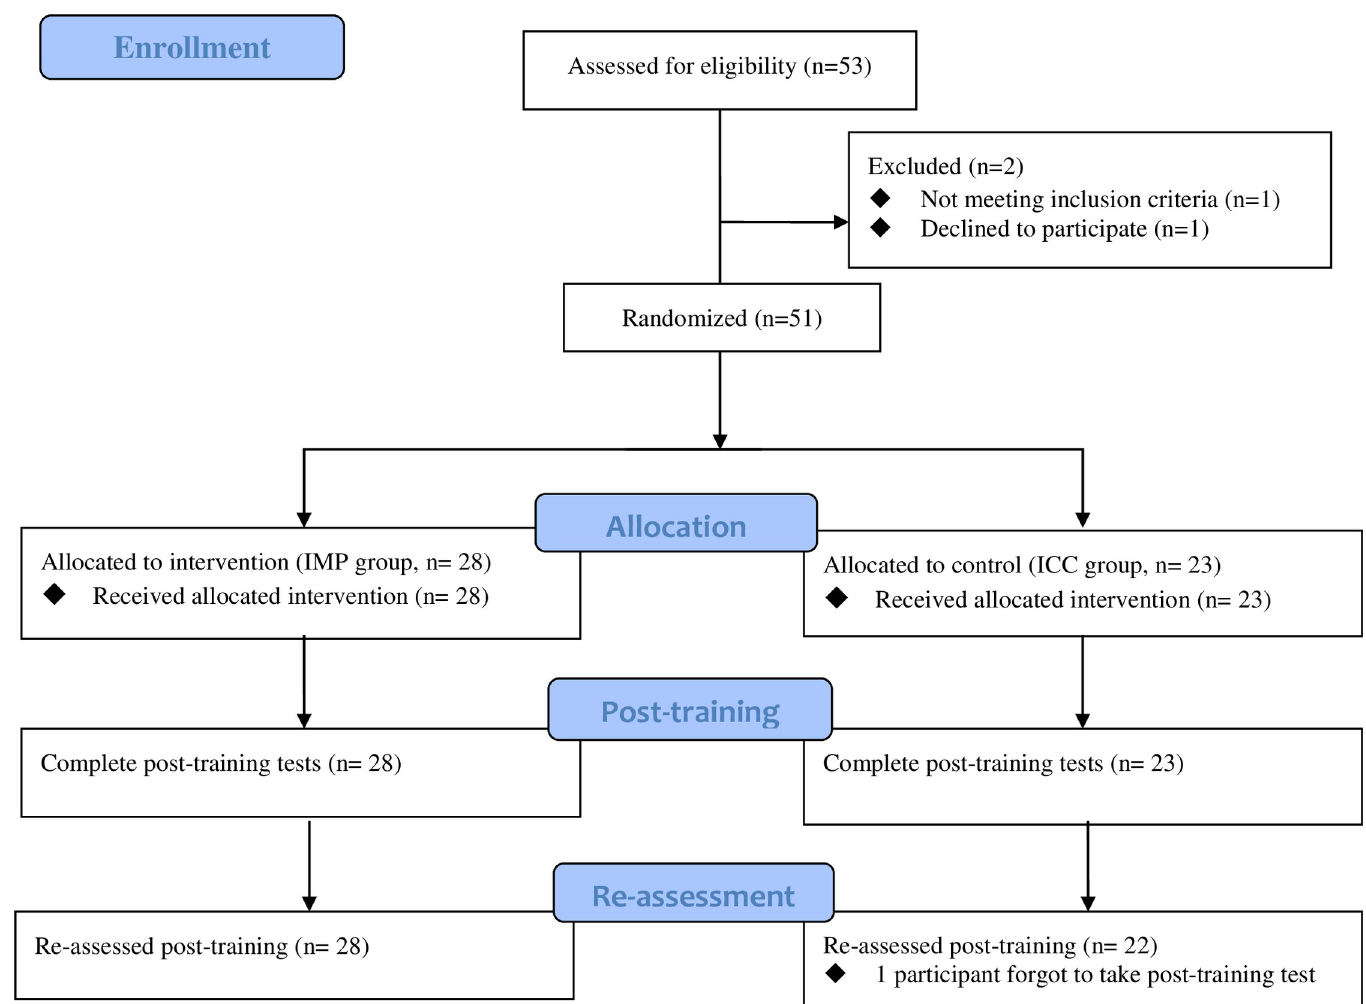
Fig 1. Flowchart depicting the passage of